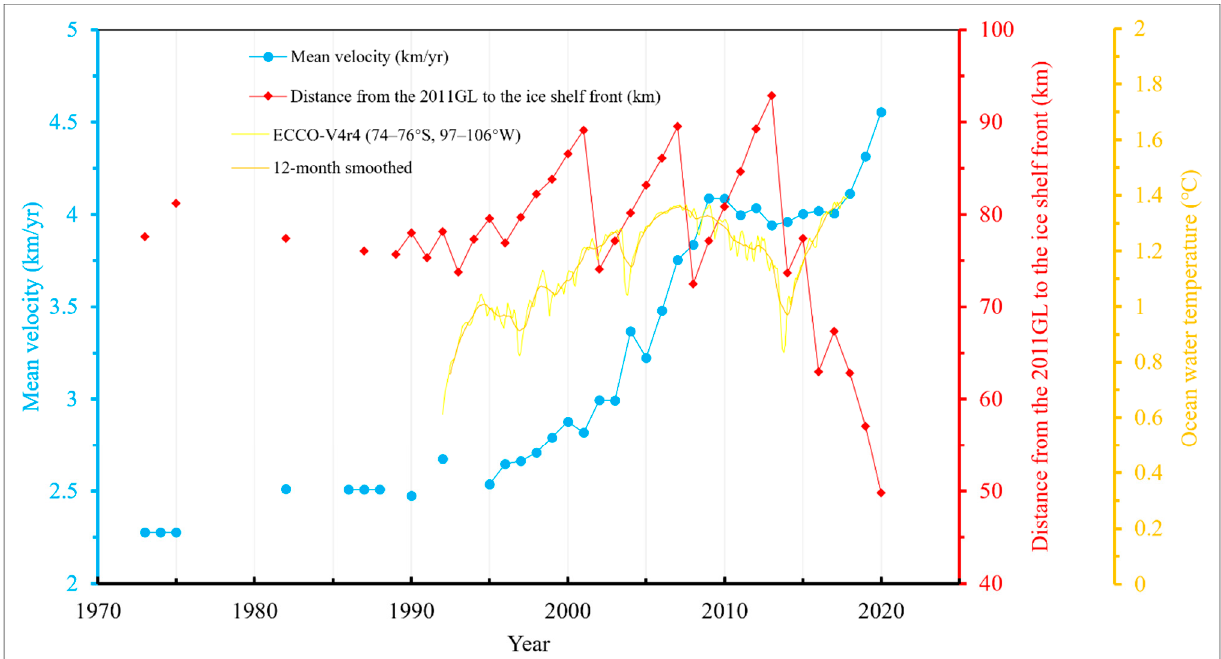
Figure 2. The ice flow velocity profiles along F-F’ from 1973 to 2020. Velocities of 1973–1975, 1986– 1988, 1996, 2002, and 2006 were retrieved via NSIDC [27,41] .